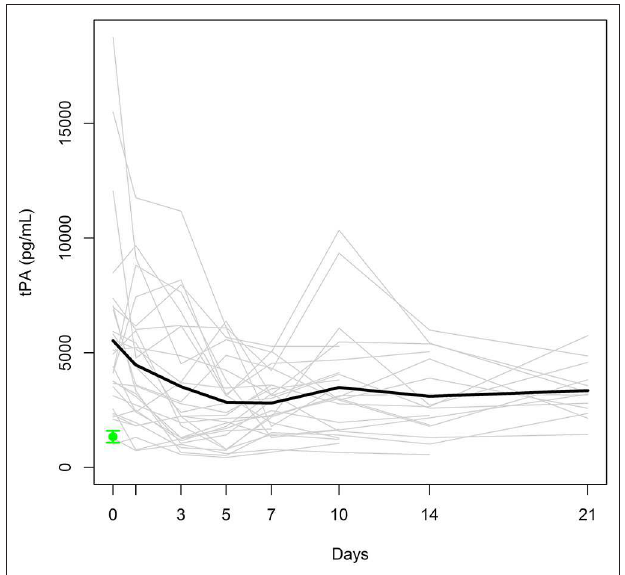
FIGURE 1 | Individual tPA antigen levels (gray lines) and mean tPA antigen level (black bold line) in the study group. Mean ± SEM of tPA in healthy controls (green).